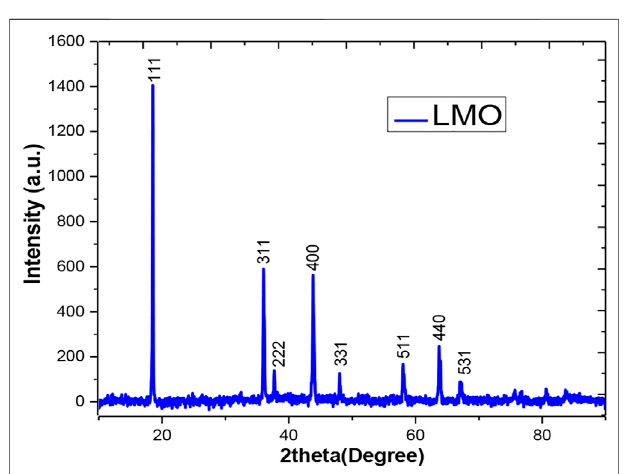
FIGURE 2 | XRD pattern of the synthesized LMO sample.